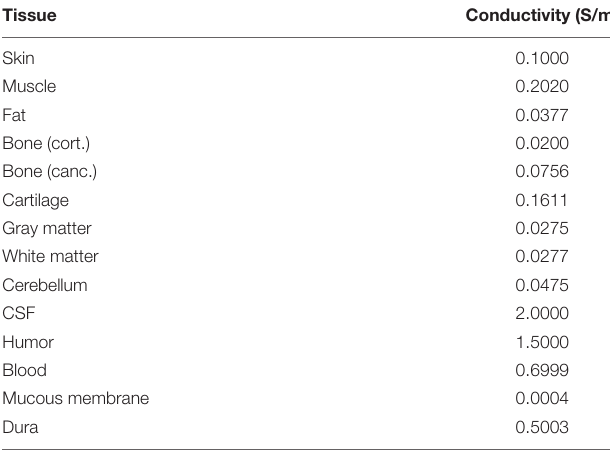
TABLE 1 | Conductivity of each tissue.